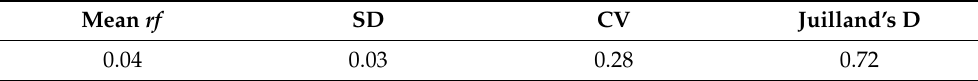
Table 9. Dispersion analysis of the central word among the sections for the year